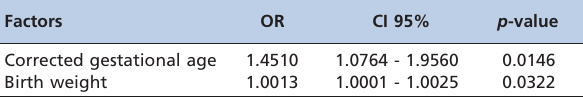
Table 3 - Multiple regression analysis of the factors associated with the success of the oral feeding after the first